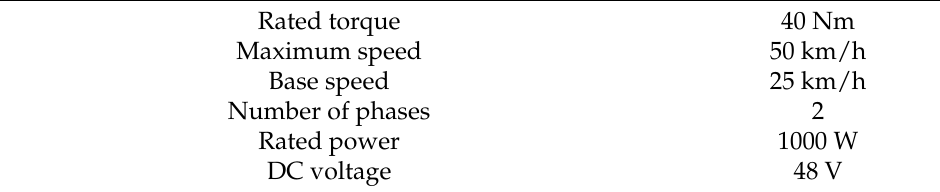
Table 3. Vehicle requirements regarding the electric